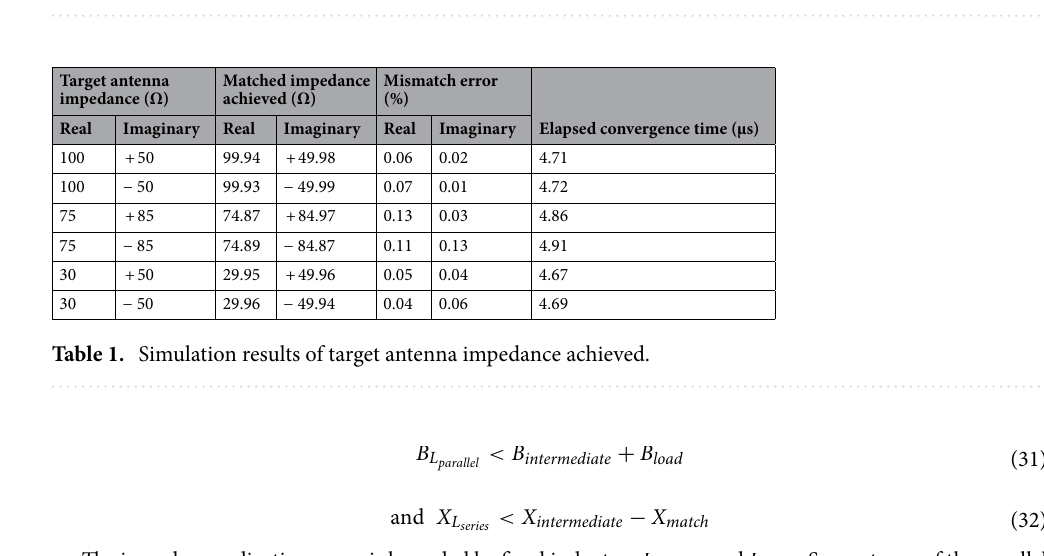
Figure 9. LC -network implemented. An extra feedback path is shown in dotted ‘green’ blocks. This feedback ensures the first and second loops to function in their stable regions.